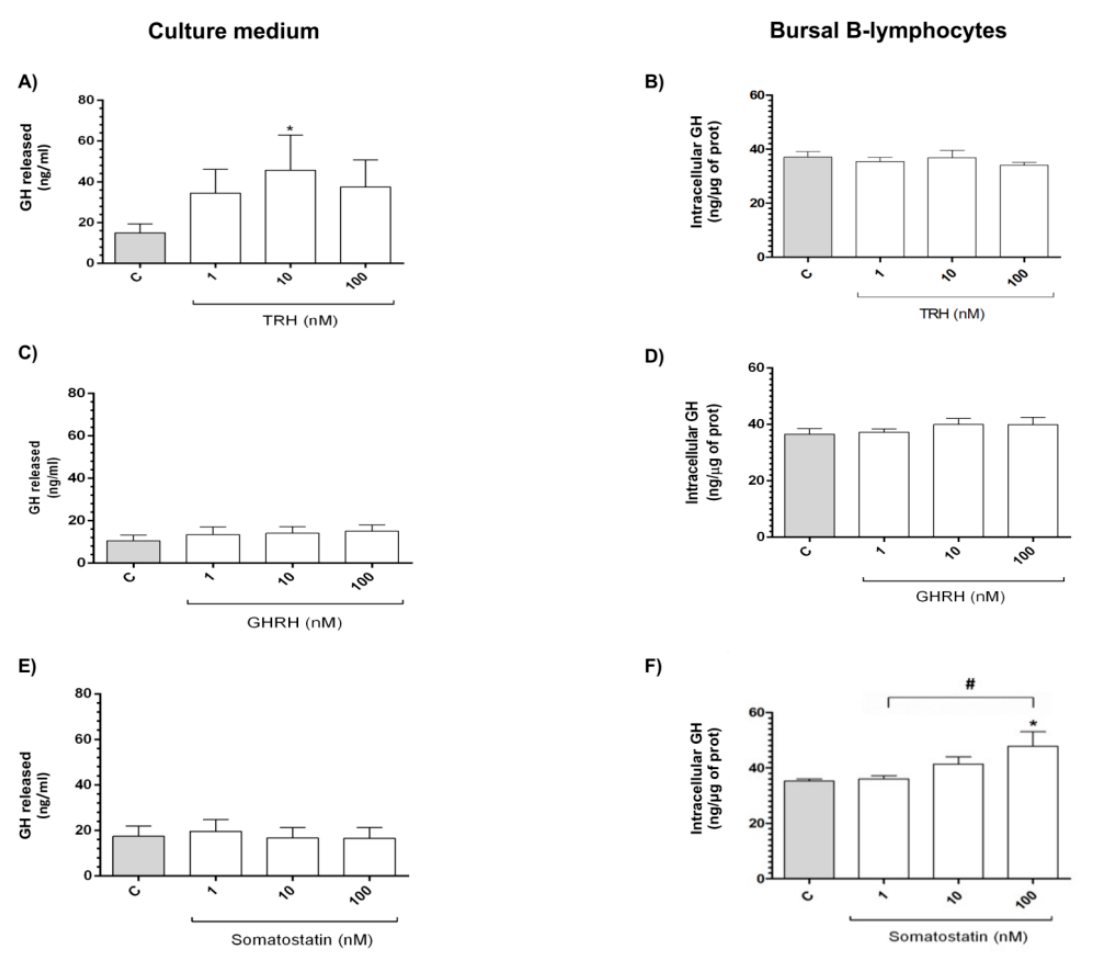
Figure 5. TRH, GHRH, and SST effects upon GH synthesis and release in BBLs. Intracellular ( B , D , F ) and released ( A , C , E ) GH were determined by ELISA in B-bursal lymphocyte cultures in response to TRH, GHRH, and SST (1, 10, and 100 nM). Each bar represents means ± SEM. Data was obtained from seven independent experiments for cellular fraction and five independent experiments for culture media. Asterisks represent significant differences between control group (* p < 0.05) using one-way ANOVA for multiple comparisons and non-parametric Dunn´s post-hoc test for TRH and parametric Šidák post-hoc test for SST. Number sign represents the differences between experimental groups (# p < 0.05).